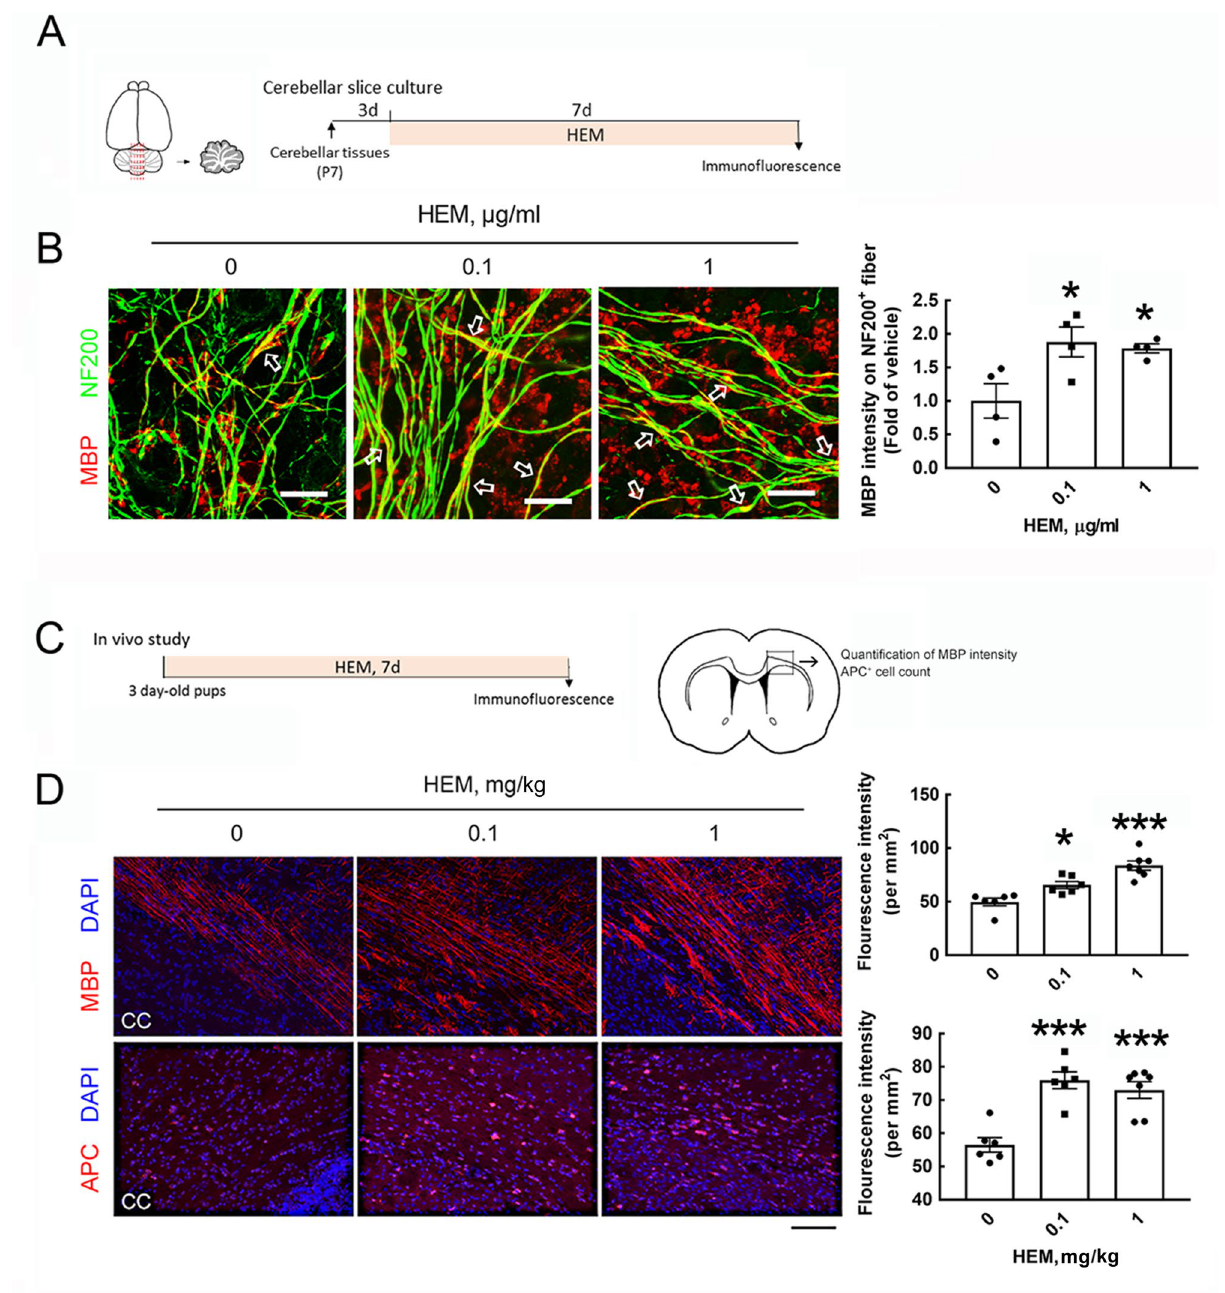
Figure 3. Ex vivo and in vivo experiments reveal the effect of crude HEM in stimulating MBP production and OL maturation. ( A ) Cerebellar tissue slices taken from the vermis (as indicated by red lines) were prepared from P7 rats and then cultured for 3 days. Crude HEM at concentrations of 0.1 and 1 μg/ml was added to the cultures for 7 days. The cultures were subjected to immunofluorescence for NF200 and MBP staining. ( B ) Confocal images show overlap between the immunoreactive intensity of MBP with NF200 + -fibers (arrows), which was quantified using ImageJ software. The data were obtained from four random fields per culture (right panel). The results are presented as the means ± SEMs of the four tissue slices for each treatment. Each dot denotes data obtained from one tissue slice. ( C ) For the in vivo study, crude HEM was administered to rat pups at the age of P3 orally daily for 7 consecutive days. After brains were removed and cryostat sectioned, followed by immunofluorescence for MBP or APC. MBP intensity and APC+-cells were quantified in the body portion of the corpus callosum using ImageJ software. ( D ). After immunofluorescence by anti-MBP (red) or anti-APC (red), the brain tissue sections were subjected to DAPI nuclear counterstaining (blue). The representative images in the body portion of the corpus callosum were captured by confocal microscopy, and the immunoreactive intensity of MBP and APC was then quantified as described in “Materials and methods” section. The results are presented as the means ± SEMs of 6 animals in each group. * p < 0.05, *** p < 0.001 versus the vehicle-treated control culture. Scale bar in ( B ) 20 μm; in ( D ) 50